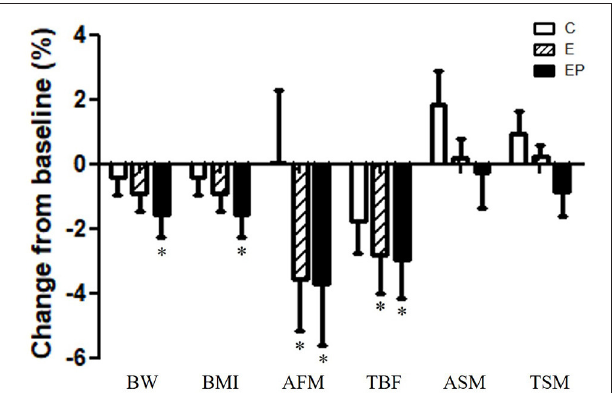
FIGURE 3 | Effects of intervention on body composition. Data were presented as mean ± SE. *Significant change from the baseline; AFM, abdominal fat mass; ASM, appendicular skeletal muscle mass; BMI, body mass index; BW, body weight; C, control group; E, exercise group; EP, exercise combined with high-protein diet group; TBF, total body fat mass; TSM, total skeletal muscle mass.